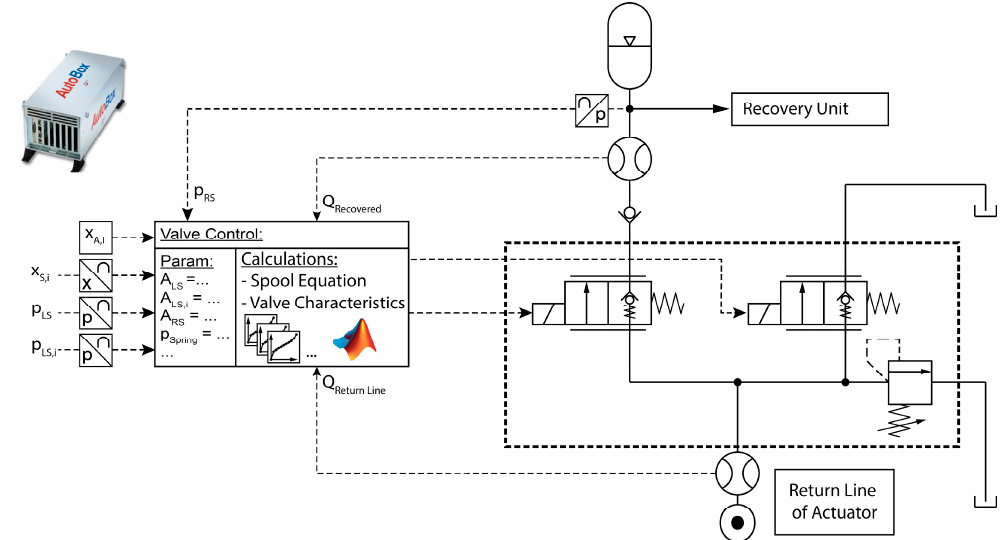
Figure 9. Scheme T/A-LV prototype. Previously published in [15]. Reproduced with permission from the publisher.